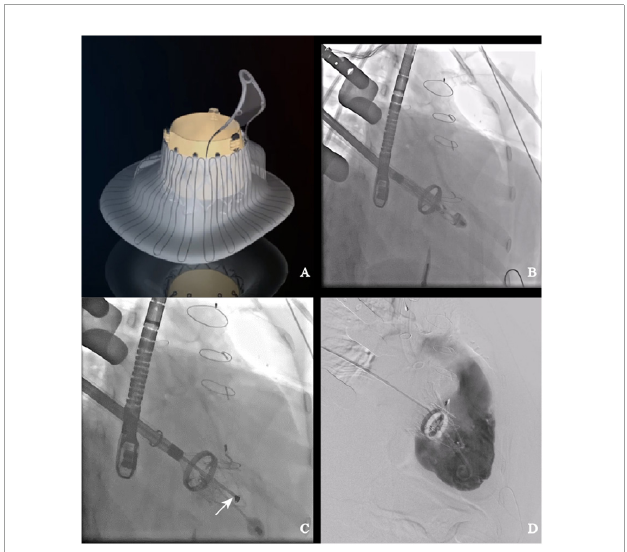
FIGURE1 LuX-Valve and its application in interventional procedure. (A) Schematic of LuX-Valve; (B) coaxiality adjustment; (C) anchoring needle (white arrow) release; (D) post-implantation.